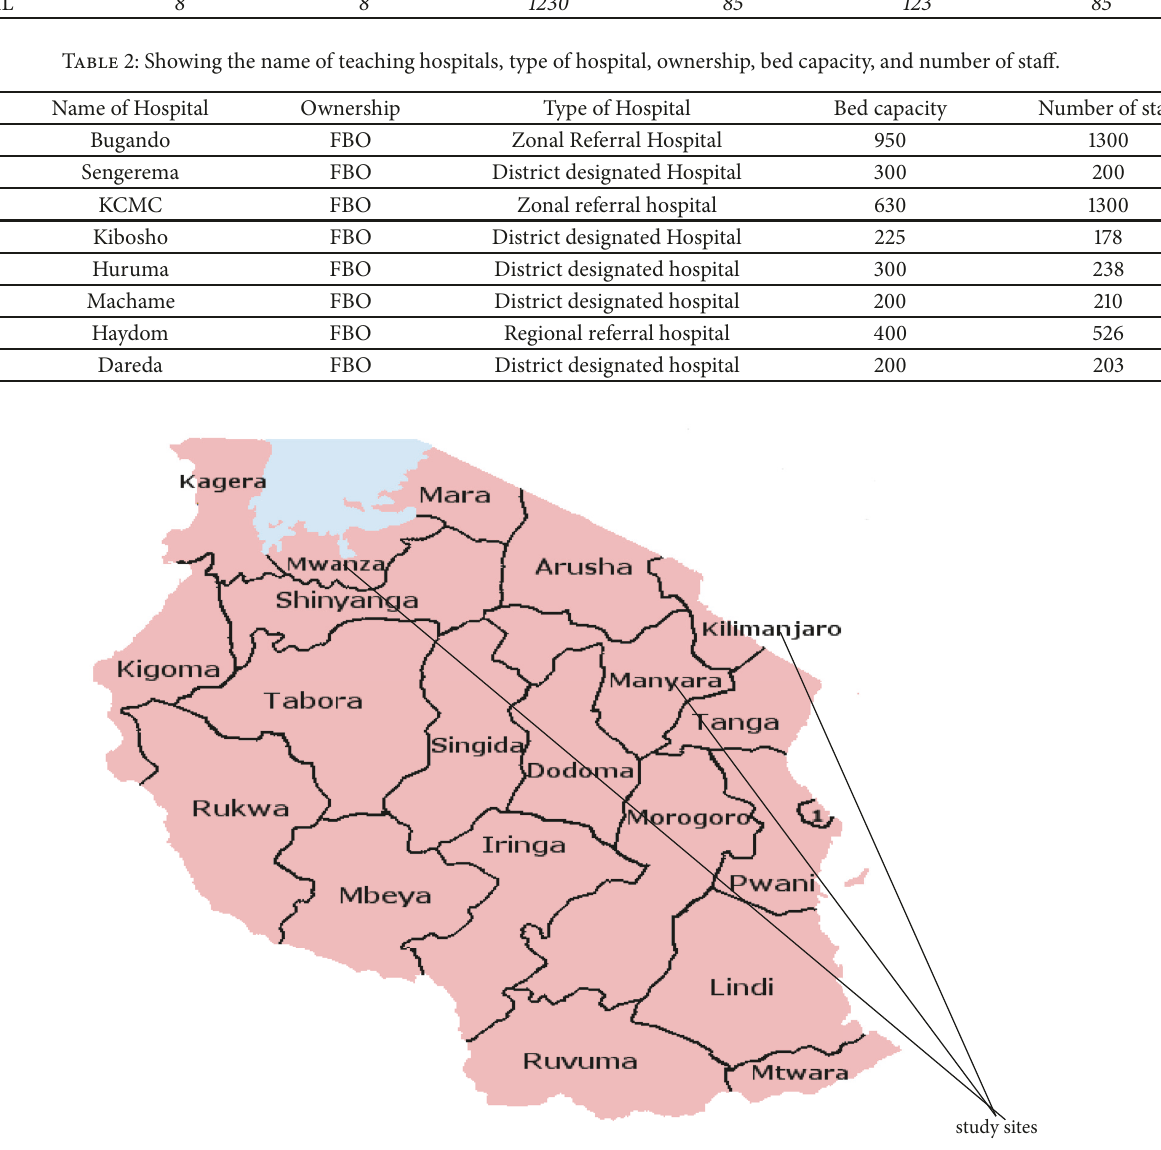
Figure 1: Map of Tanzania showing the location of study areas